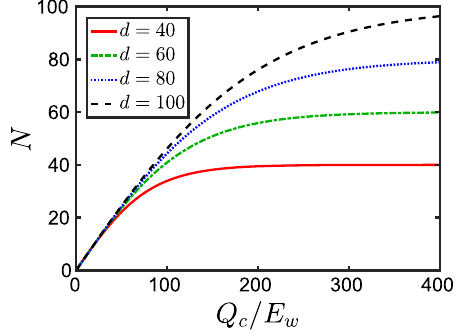
FIG. 3. Accuracy N versus dissipated energy Q values of the dimension d of the ladder, according to the approximation (8) with the same bath temperatures as in Fig.